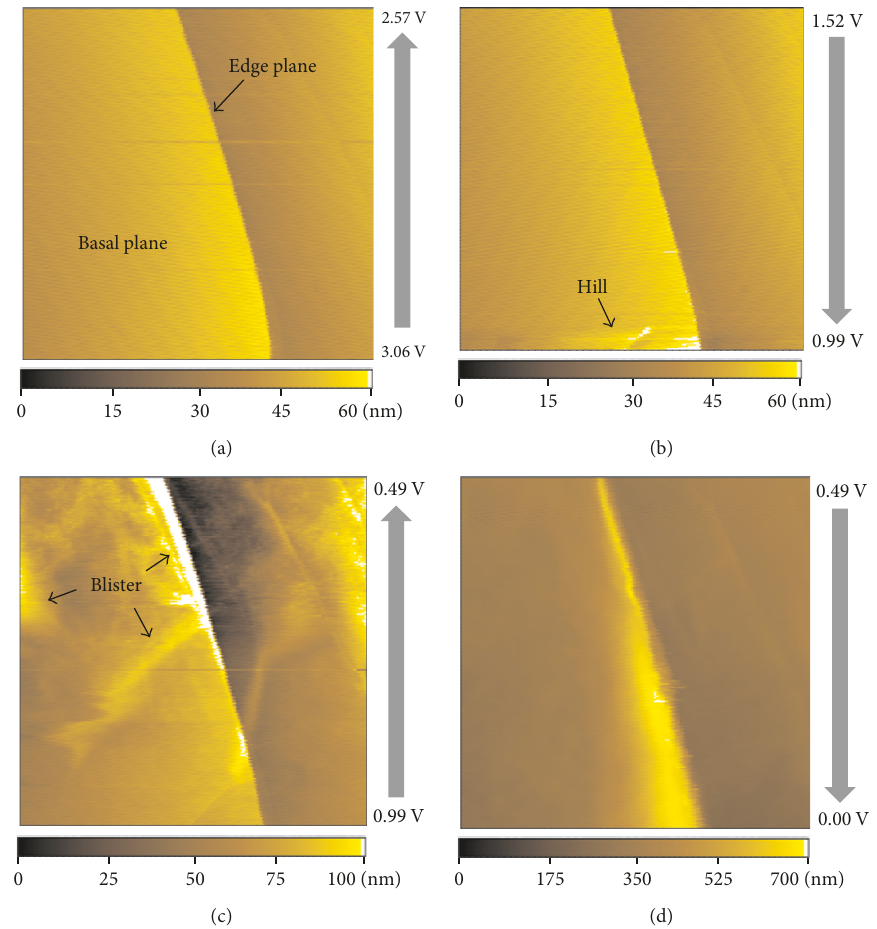
Figure 5: In situ AFM images of the HOPG basal plane (5 µ m × 5 µ m) obtained at (a) 3.06–2.57, (b) 1.52–0.99, (c) 0.99–0.49, and (d) 0.49–0.0V during the first reduction in 1M · LiClO 4